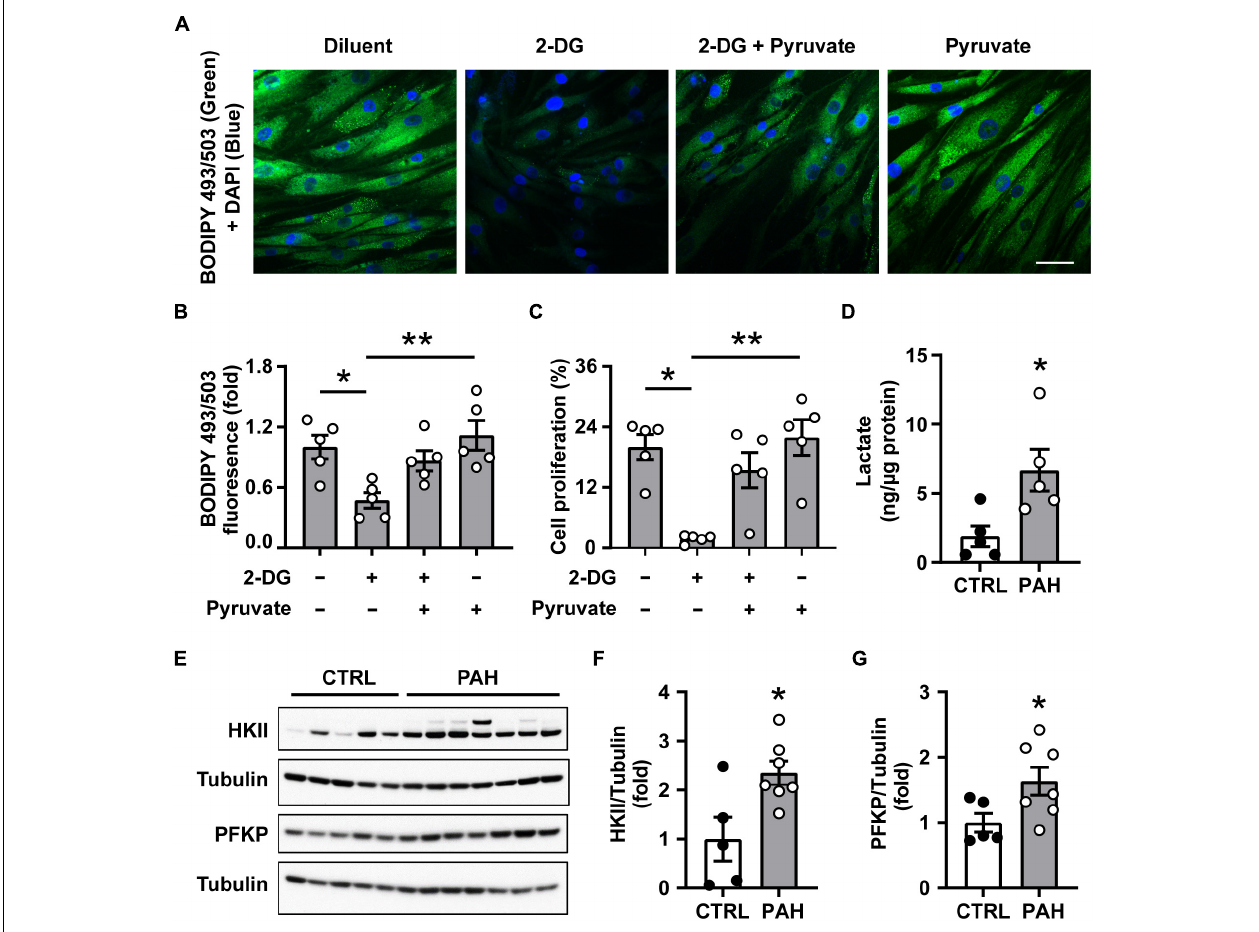
FIGURE 2 | Increased lipid synthesis in human PAH PAVSMC is glucose dependent. (A–C) Human PAH PAVSMC were incubated in serum deprived media supplemented with 0.1% lipid-deprived BSA in presence of 2-Deoxy- D -glucose (2-DG, 100 mM) and/or pyruvate (10 mM) or vehicle ( − ). Forty-eight hours later neutral lipid accumulation (A,B) was evaluated by fluorescent BODIPY 493/503 staining (green) followed by DAPI co-staining (blue) to detect nuclei and cell proliferation (Ki-67) (C) was analyzed. Representative images (A) and statistical analysis (B,C) are shown. Bar equals 50 µ m. Data are means ± SE, n = 5 subjects/group, fold to vehicle-treated group (B) , percentage of Ki-67 positive cells/total (C) , * p < 0.05, ** p < 0.01 by Kruskal–Wallis rank test with Dunn pairwise comparison post hoc test. (D) Intracellular lactate levels were measured in PAVSMC from five non-diseased and five PAH subjects. (E–G) Early passage distal primary human PAVSMC from five non-diseased (CTRL) and seven PAH subjects were serum deprived for 48 h and subjected to immunoblot analysis to detect indicated proteins. (D,F,G) Data are means ± SE, fold to control (F,G) , * p < 0.05 by Mann–Whitney U test.